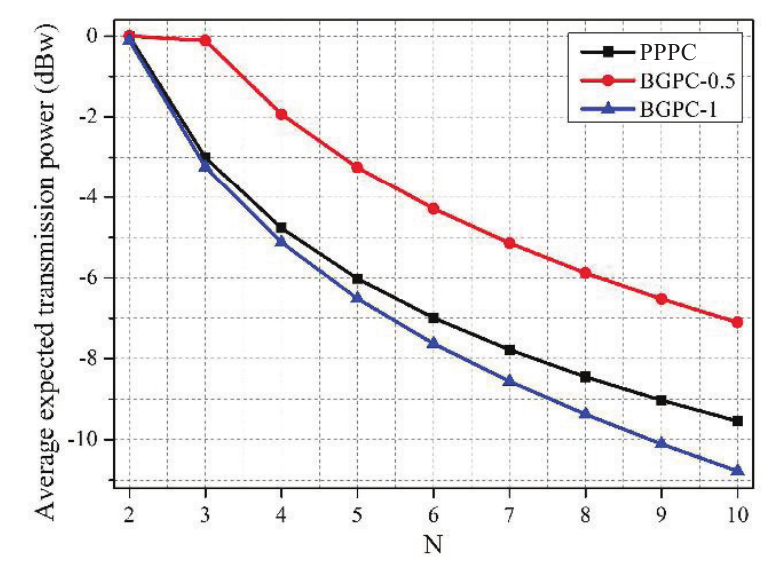
Figure 10. Average expected transmission power vs. N under schemes with different pricing